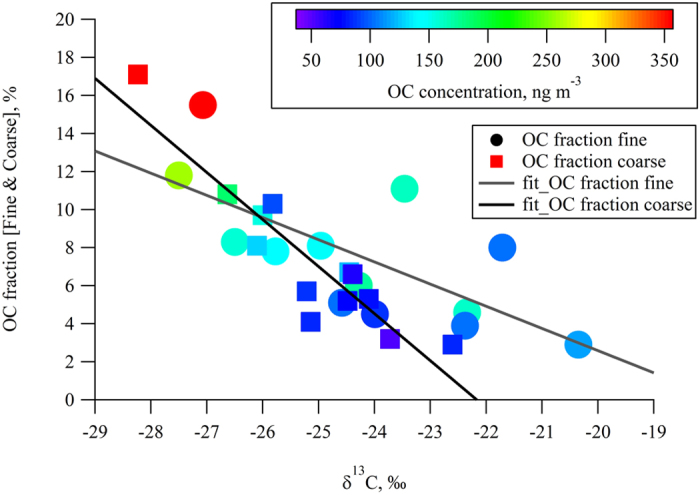
OC fraction vs δ13C (HCO3− corrected) in fine (<2.5 μm in diameter) and coarse (>2.5 μm in diameter) particles at Amsterdam Island during the austral summer of 2007.